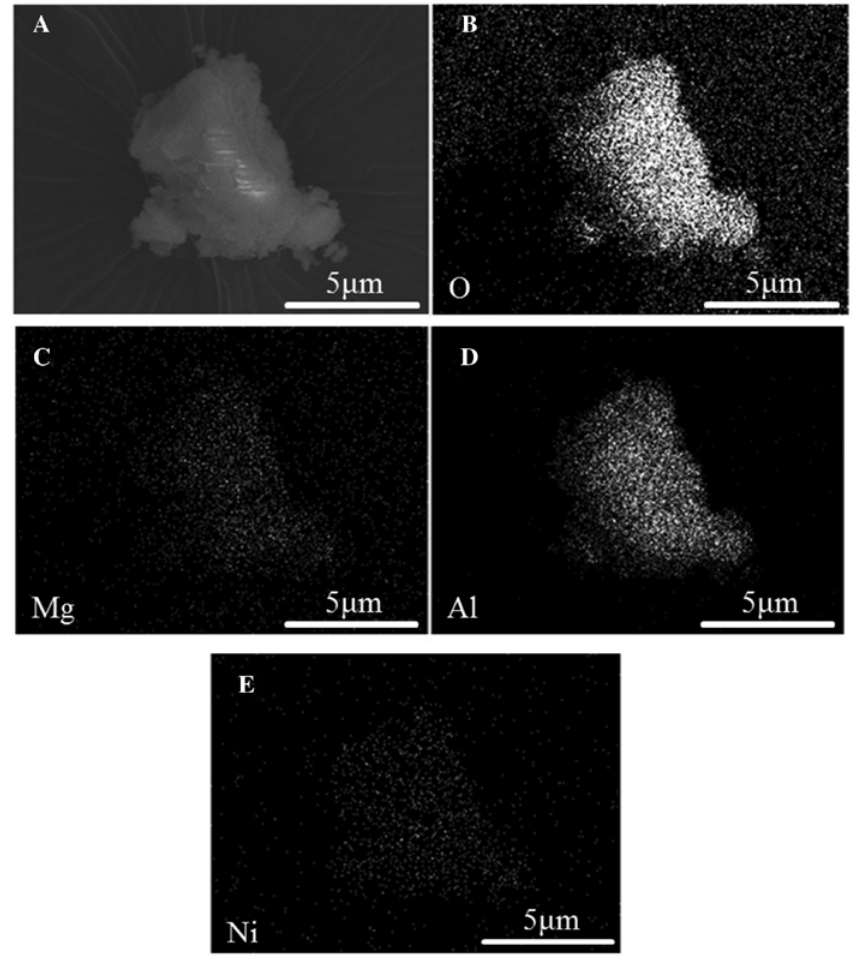
Figure 5: SEM image of the reduced Ni-0.25MA (A) and elemental mapping images of O (B), Mg (C), Al (D), and Ni